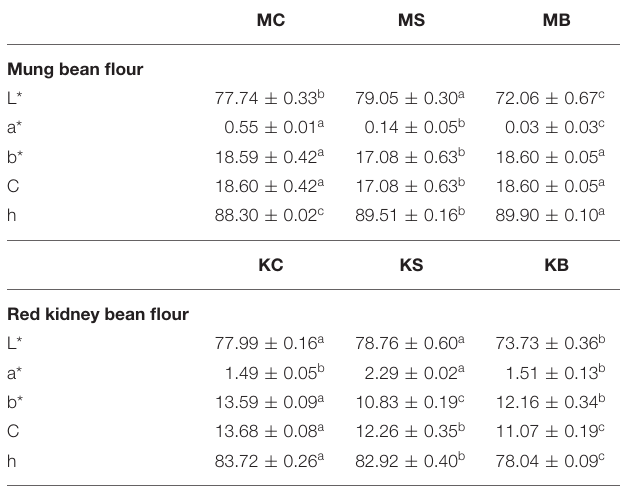
TABLE 3 | Color parameters of bean